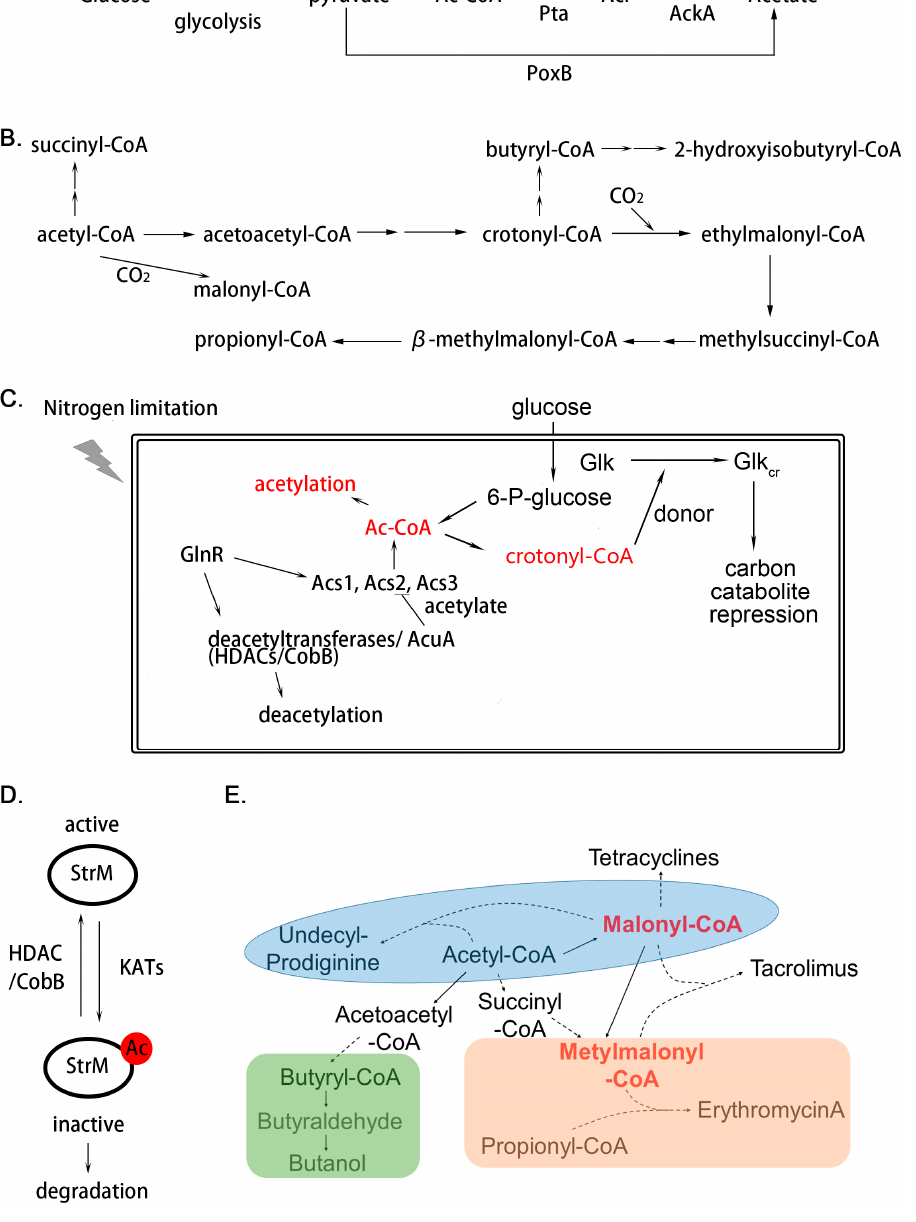
Figure2. RegulationmechanismofacylationinActinomycetes. ( A )Sourceofintracellularacetyl-phosphate (AcP) synthesized from glycolysis. In bacteria, acetate can be interconverted to acetyl-CoA (Ac-CoA) through acetate kinase (AckA) and phosphotransacetylase (Pta) reversibly. The pyruvate oxidase (PoxB) is another way for acetate synthesis; ( B ) biosynthetic pathway of Acyl-CoAs derived from acetyl-CoA; ( C ) regulation mechanism in the terms of acylation responding to extracellular nutrient fluctuation; ( D , E ) two types of regulation mechanisms in secondary metabolism through acylation. Protein acylation would result in suppression of enzyme activity and decreased stability; ( D ) In secondary metabolites biosynthesis, acyl-CoAs also act as important precursors of diverse acyl-CoA-derived natural products; ( E ) solid line indicates that the product is synthesized directly; the dotted line indicates indirect